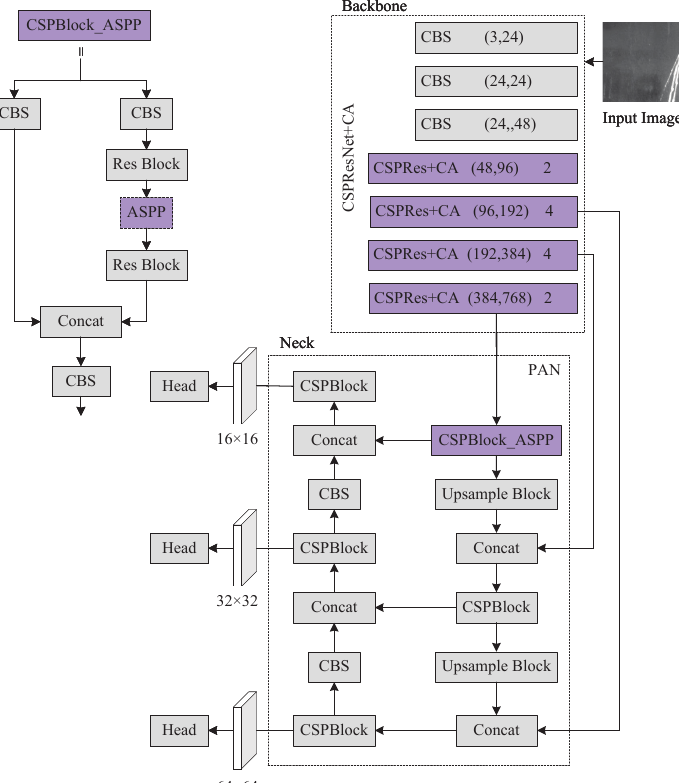
Figure 2. The improved PP-YOLOE-m network structure.